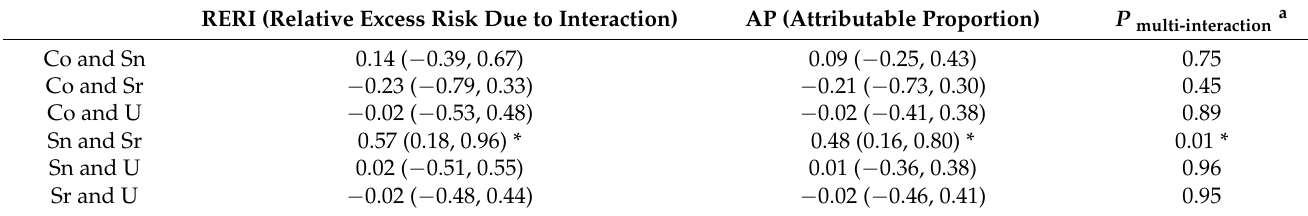
Figure 3. Dose–response relationships of urinary metals and prevalence of type 2 diabetes in the restricted cubic spline analysis. Model adjusted for sex, age, race/ethnicity, educational attainment, poverty-income ratio, smoking status, alcohol consumption, physical activity, body mass index, average daily energy intake, family history of diabetes, hypertension, alanine aminotransferase, gamma-glutamyl transferase, and estimated glomerular filtration rate. The interaction analyses showed both positive additive (RERI = 0.57, 95% C.I. = 0.18 to 0.96; AP = 0.48, 95% C.I. = 0.16 to 0.80) and multiplicative ( P multi-interaction = 0.01) interactions between urinary Sn and Sr with T2D. There was no additive or multiplicative interaction between other metal–metal pairs with T2D (Table 2 and Figure S5). Comparing to participants with Sn ≥ 4.57 * 10 − 2 µ g/g of Cr (median value) and Sr < 9.53 * 10 − 2 µ g/g of Cr (median value), the lowest odds of T2D were observed in those with urinary Sn < 4.57 * 10 − 2 µ g/g of Table 2. Interactions between urinary metals and type 2 diabetes.